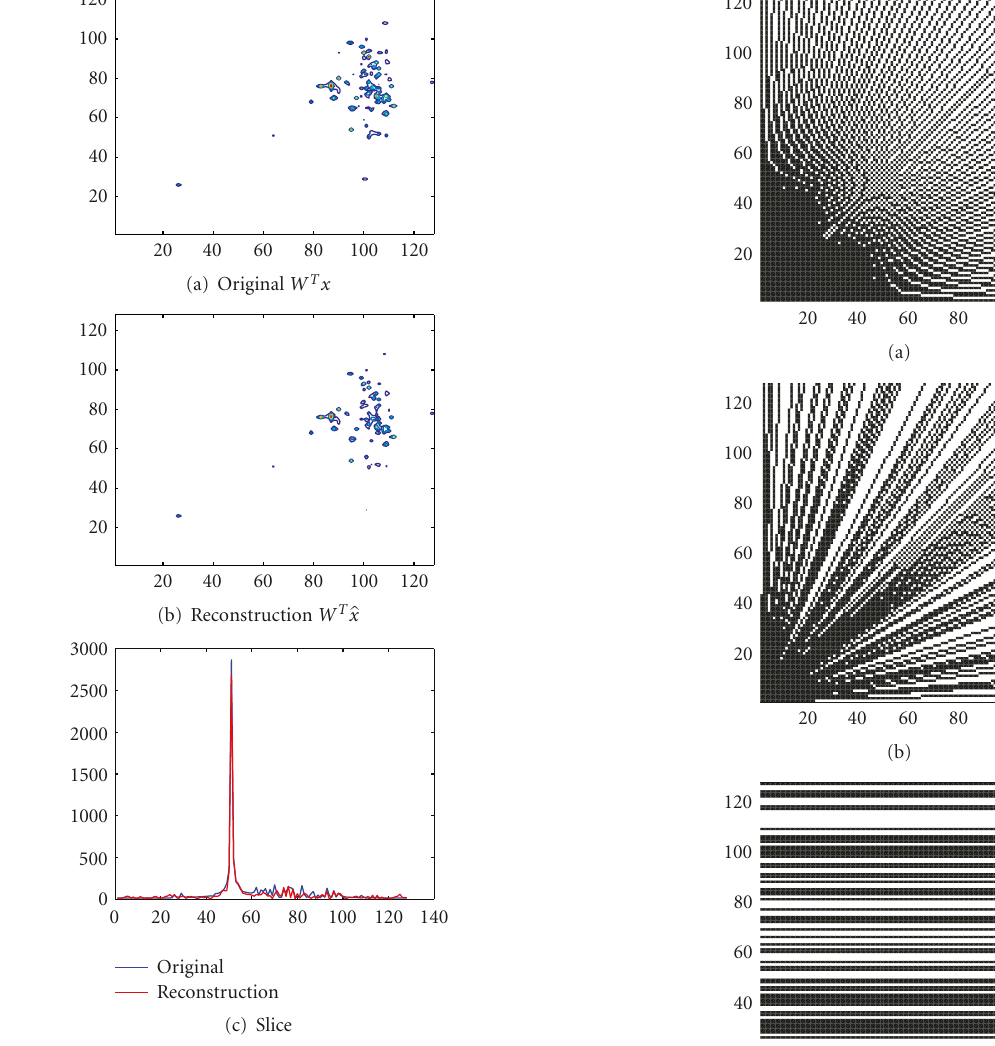
Figure 1: (a) Original spectrum. (b) (cid:2) 1 norm reconstruction. (c) Slice of original and reconstructed result.